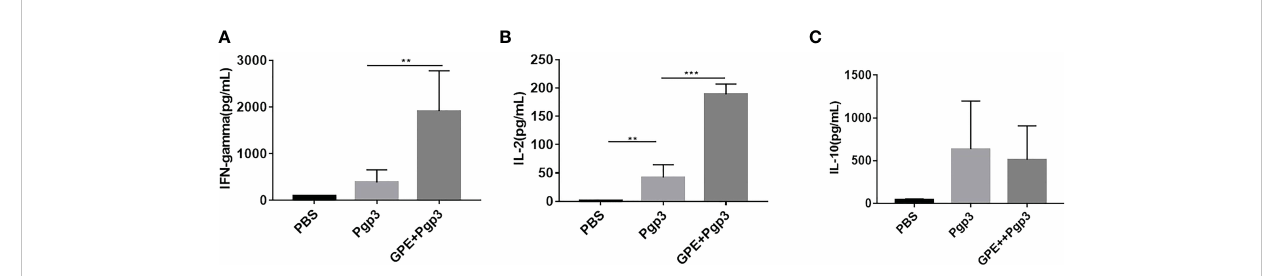
FIGURE 9 Cytokine (A) , IFN- g (B) , IL-2 (C) . IL-10 level of splenocyte culture supernatant of BALB/c mice (mice were sacri fi ced 2 weeks after the fi nal immunization. Spleen cells were stimulated by 10 m g Pgp3 for 48 h to collect the supernatant for an ELISA test ( n = 5)). ELISA, enzyme-linked immunosorbent